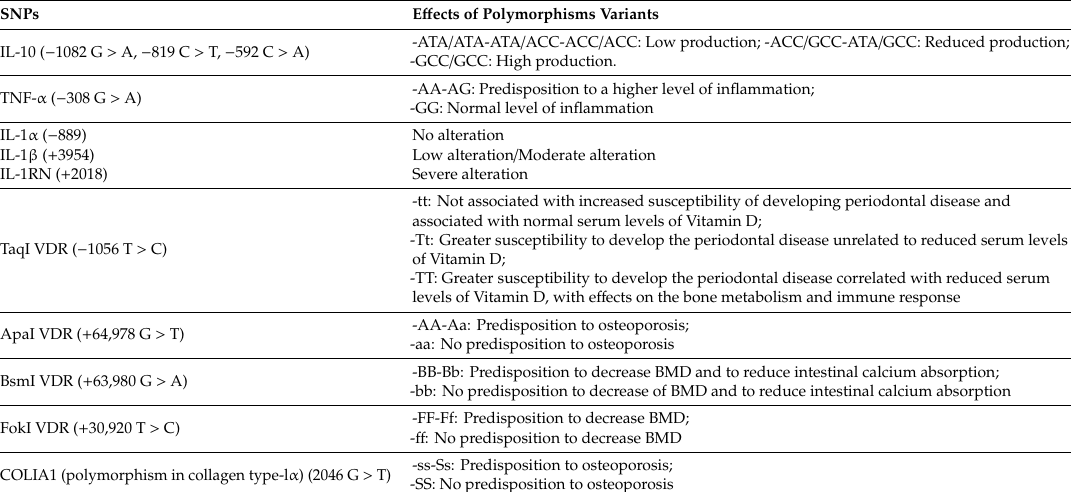
Table 1. Value legend. E ff ects of Polymorphisms